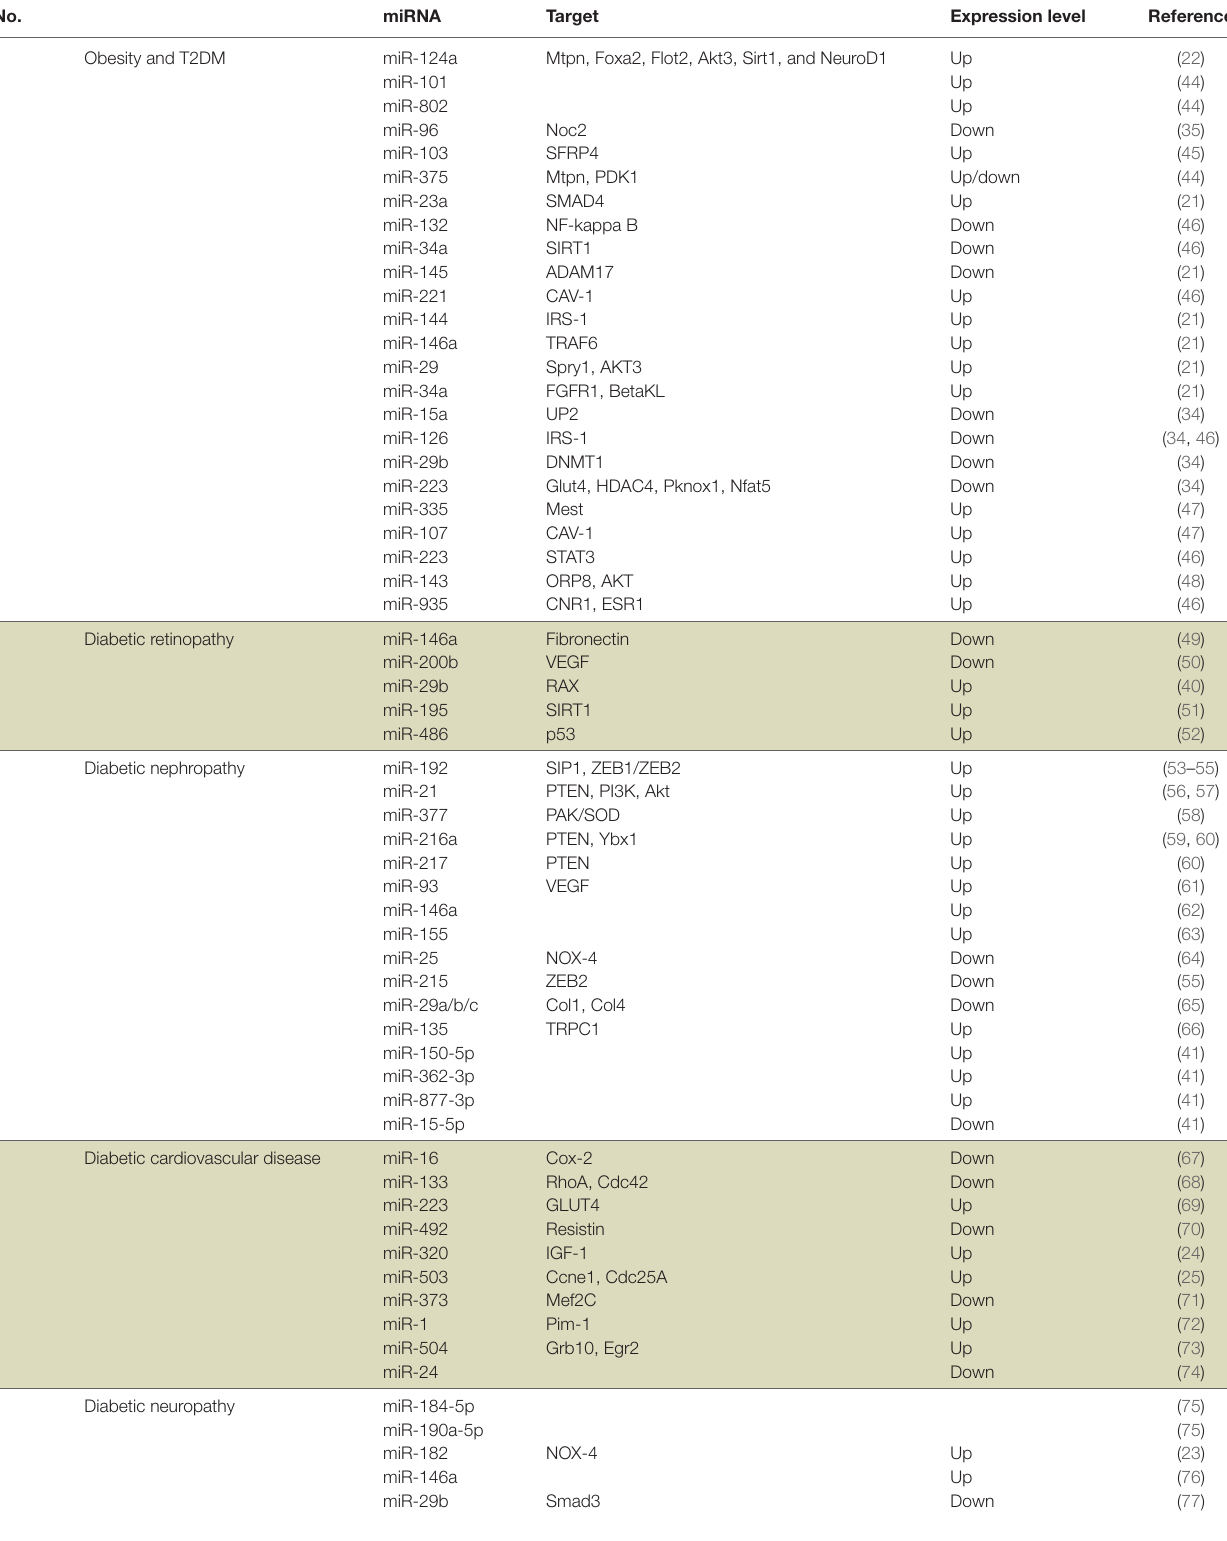
TABLe 1 | MicroRNAs (miRNAs) associated with type 2 diabetes mellitus (T2DM) and associated complications. S.